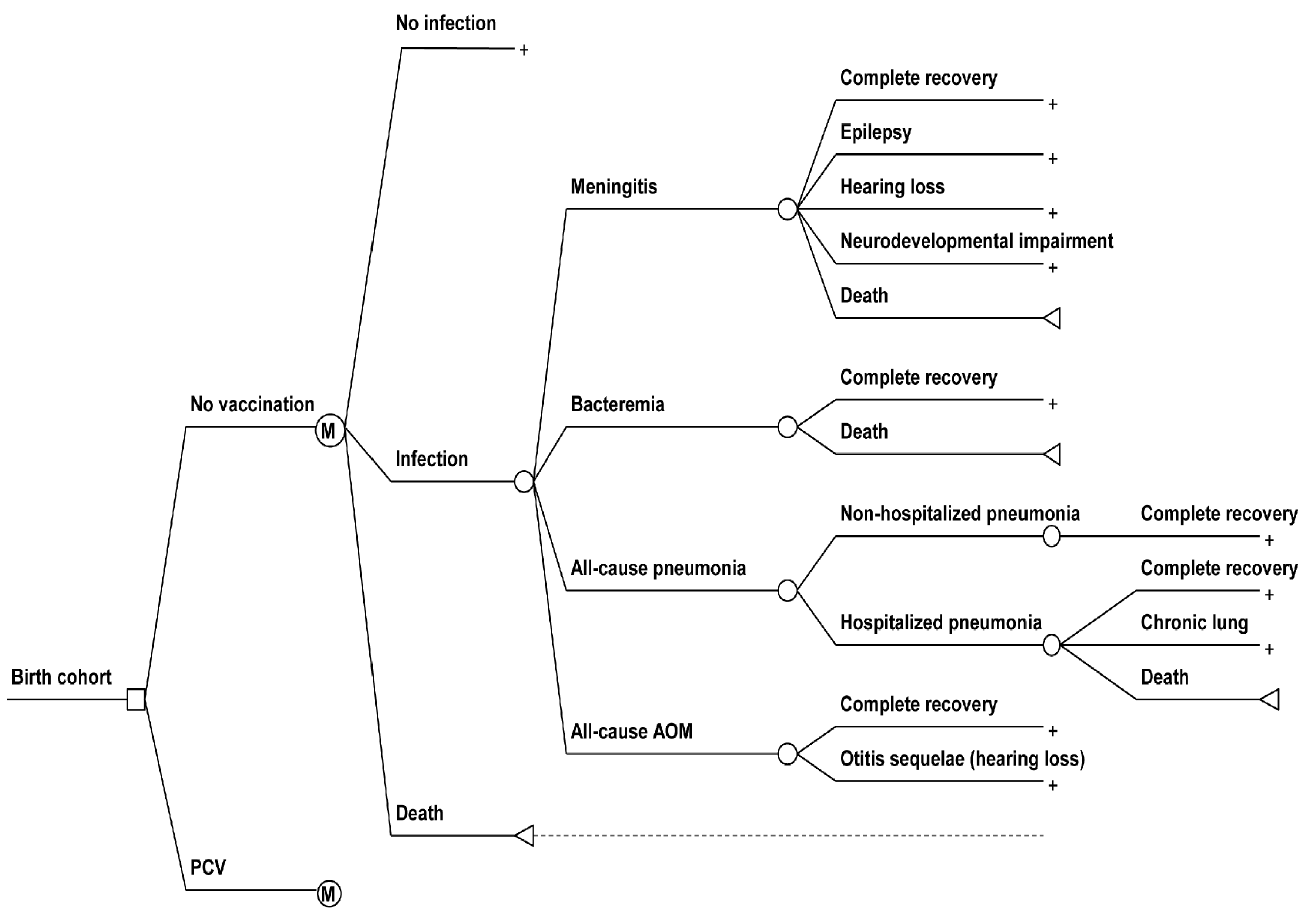
Fig 1. Markov model used for assessing the health and economic impact of pneumococcal conjugate vaccine (PCV) vaccination compared to ‘ no vaccination ’ . The structure of the PCV node was omitted in the figure, as it is identical to the ‘ no vaccination ’ node.